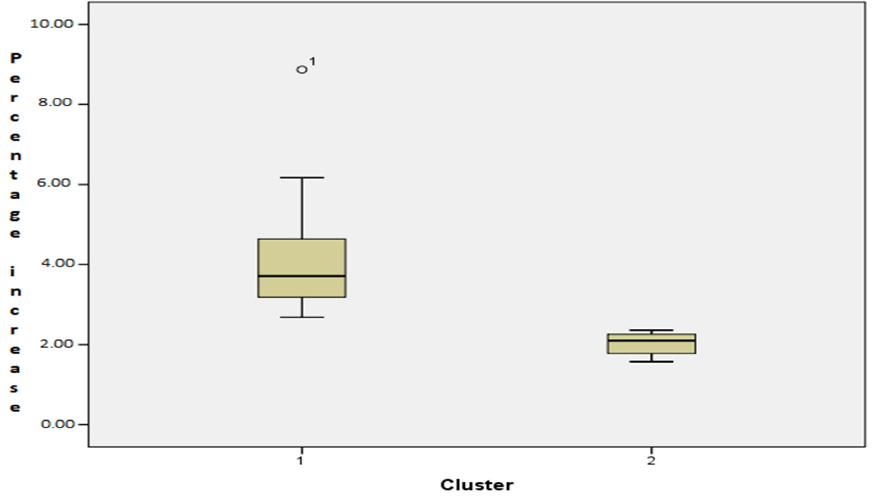
Figure 4. Box-plot cluster. Source: own processing data in SPSS 23.